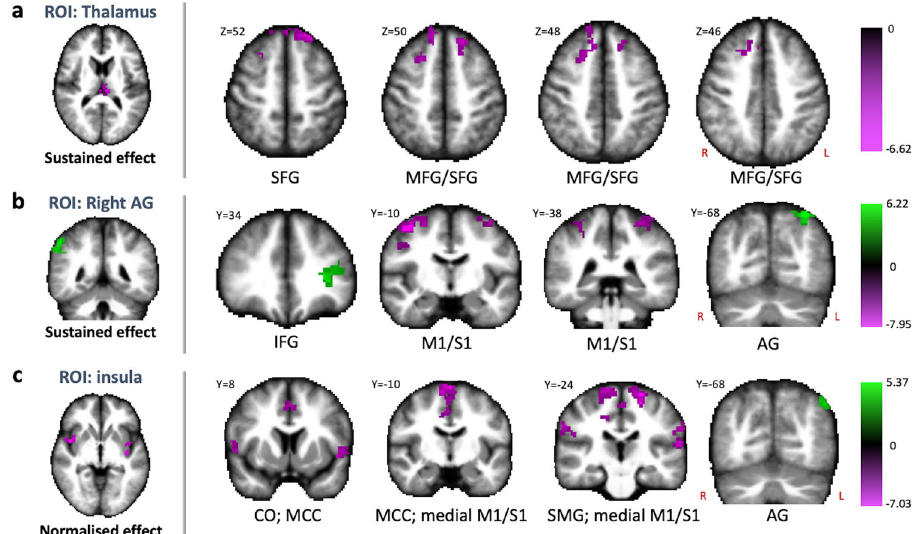
Fig. 5 Seed-based connectivity changes after space fl ight of the thalamus, right angular gyrus, and bilateral insula. The longitudinal changes in intrinsic connectivity contrast (ICC) for the thalamus ( a ), right angular gyrus ( b ), and bilateral insula ( c ) were associated with connectivity increases (green) and decreases (magenta) with speci fi c brain regions. The posterior cingulate cortex did not exhibit connectivity changes with other speci fi c brain regions. Slice coordinates are presented in MNI space. Color maps present statistical t -values. AG angular gyrus, CO central operculum, IFG inferior frontal gyrus, M1/S1 pre- and postcentral gyrus, MCC middle cingulate cortex, MFG middle frontal gyrus, ROI region of interest, SFG superior frontal gyrus. SMG supramarginal gyrus. R right, L left. Statistical signi fi cance is based on p < 0.005 uncorrected at the voxel level followed by p < 0.05 corrected for family-wise error at the cluster level ( n =